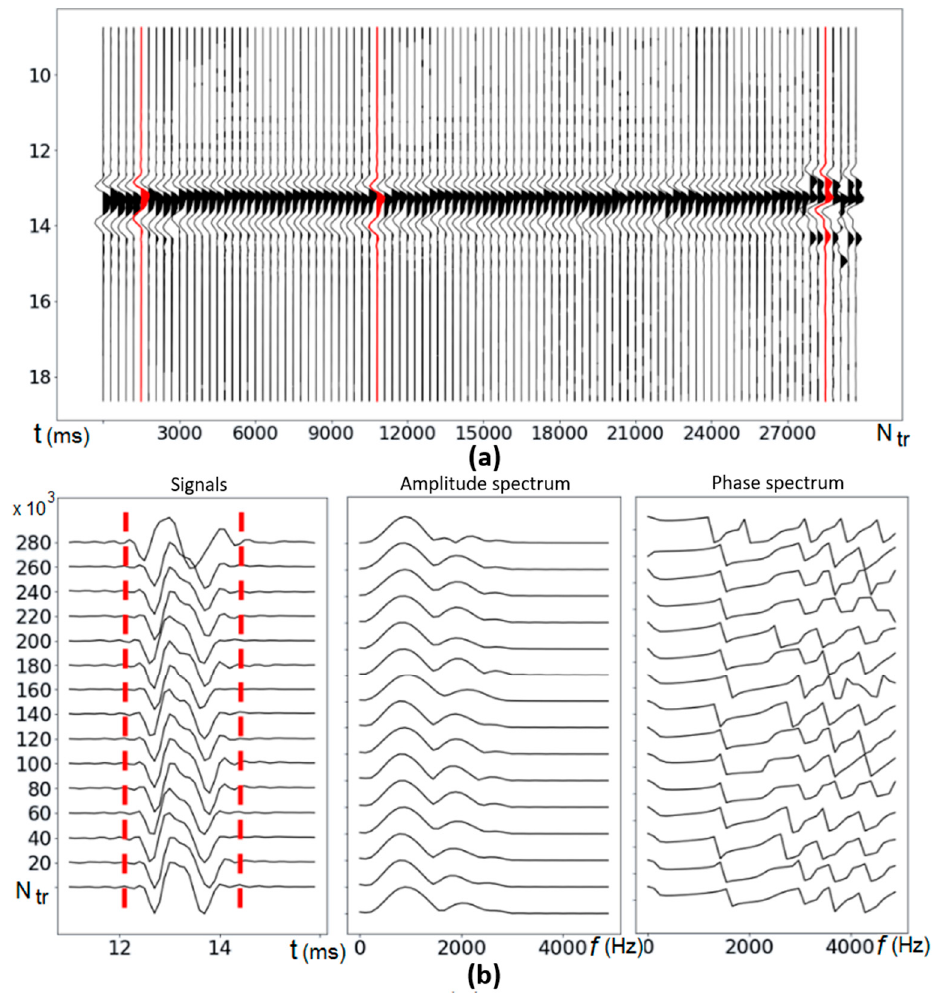
Figure 3. Analysis of signals of the direct wave after deconvolution. ( a ) A part of the wavefield. ( b ) From left to right: Analyzed signals and their amplitude and phase spectra. Red markers show a narrow time interval for calculating spectra.